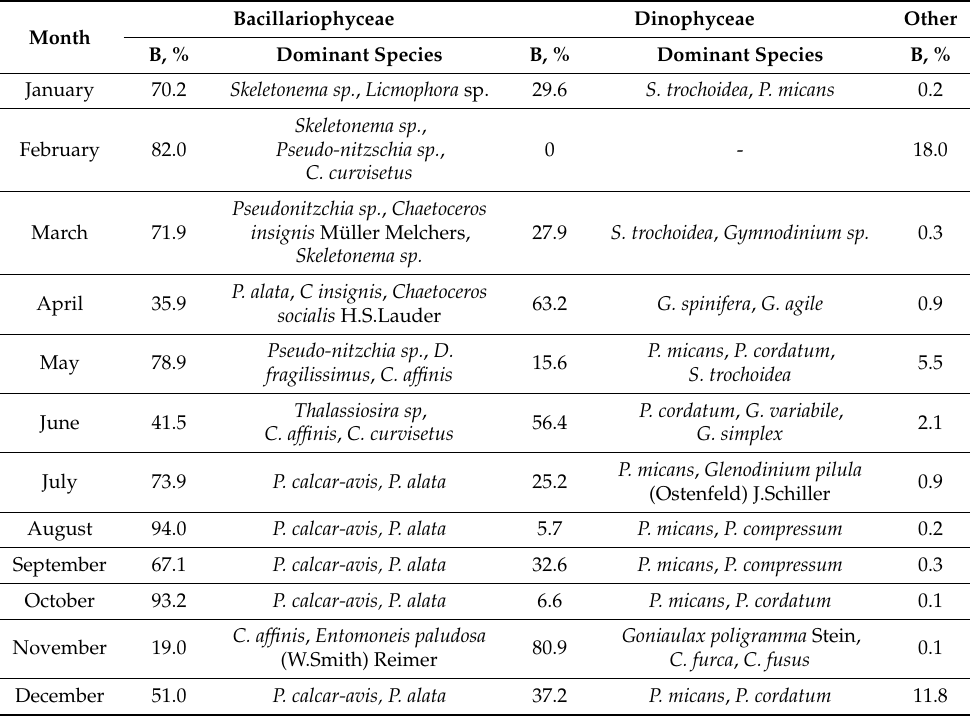
Figure 3. Seasonal variability: ( a ) phytoplankton growth rate (1), microzooplankton grazing (2) and average phytoplankton cell volume (3); ( b ) chlorophyll a concentration (1), phytoplankton biomass (2), water temperature (3); ( c ) nitrate (1), silicate (2), phosphate (3); ( d ) the permanganate oxidizability (1) in Station 2. Table 2. Relative biomass (B) and dominant species of diatoms (Bacillariophyceae) and dinoflagellates (Dinophyceae) in the phytoplankton of Station 2 in